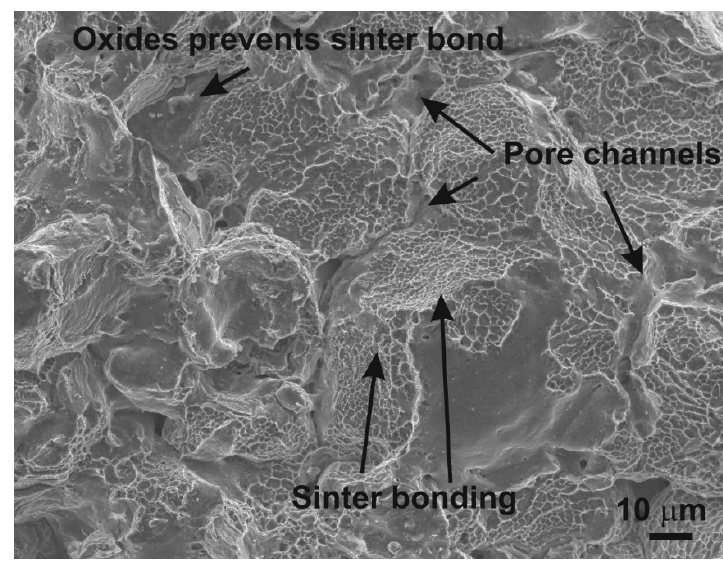
Figure 6. Sintering process and their typical features.